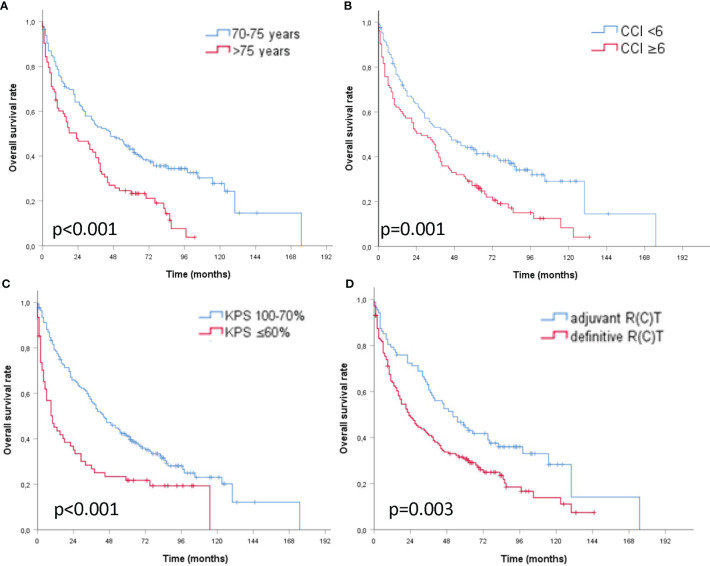
| Kaplan–Meier curves of older patients with head and neck cancer and curative (chemo) radiation (A) age ≤75 vs. >75 years (B) CCI <6 vs. ≥6 points (C) KPS ≥70 vs. <70% (D) adjuvant vs. definitive (chemo) radiation with respect to overall survival.